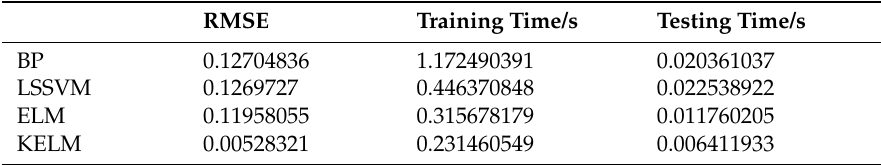
Table 3. The comparison of the training time, the testing time, and the root mean square errors